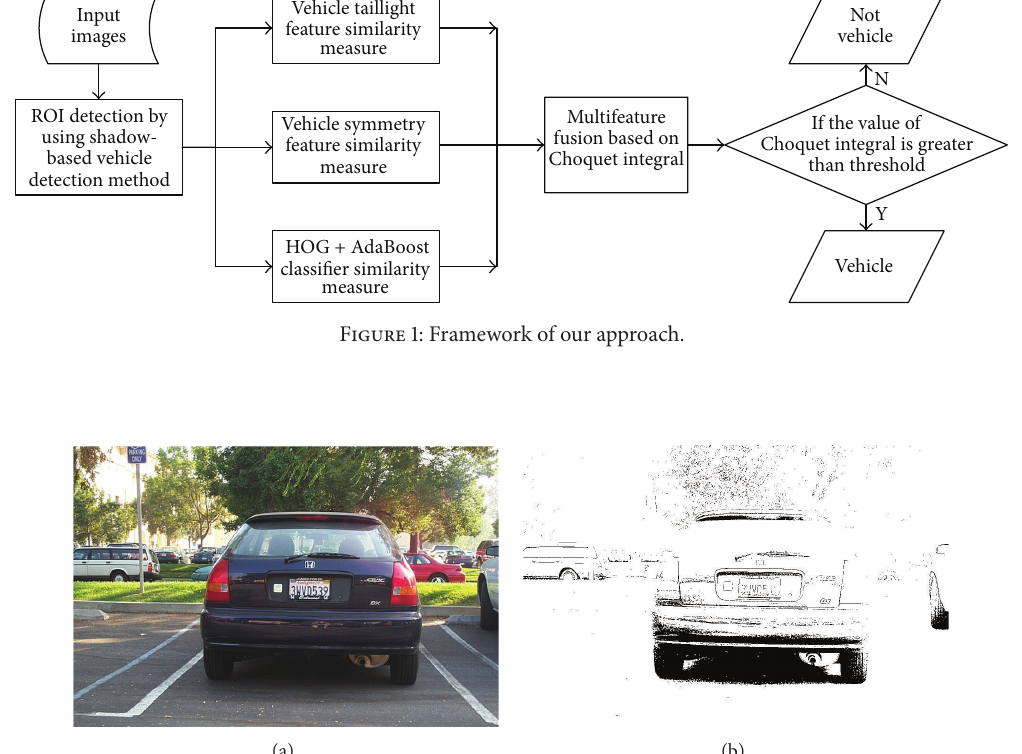
based vehicle detection method. Figure 4(b) is the binary image of taillights detected by employing (1) on the vehicle ROI. Canny-based edge detection method is used to detect edge image of Figure 4(b). Then the connected domains in Figure 4(c) are extracted. The input images of connected domain extraction method are binary and edge image which are illustrated as Figures 4(b) and 4(c),